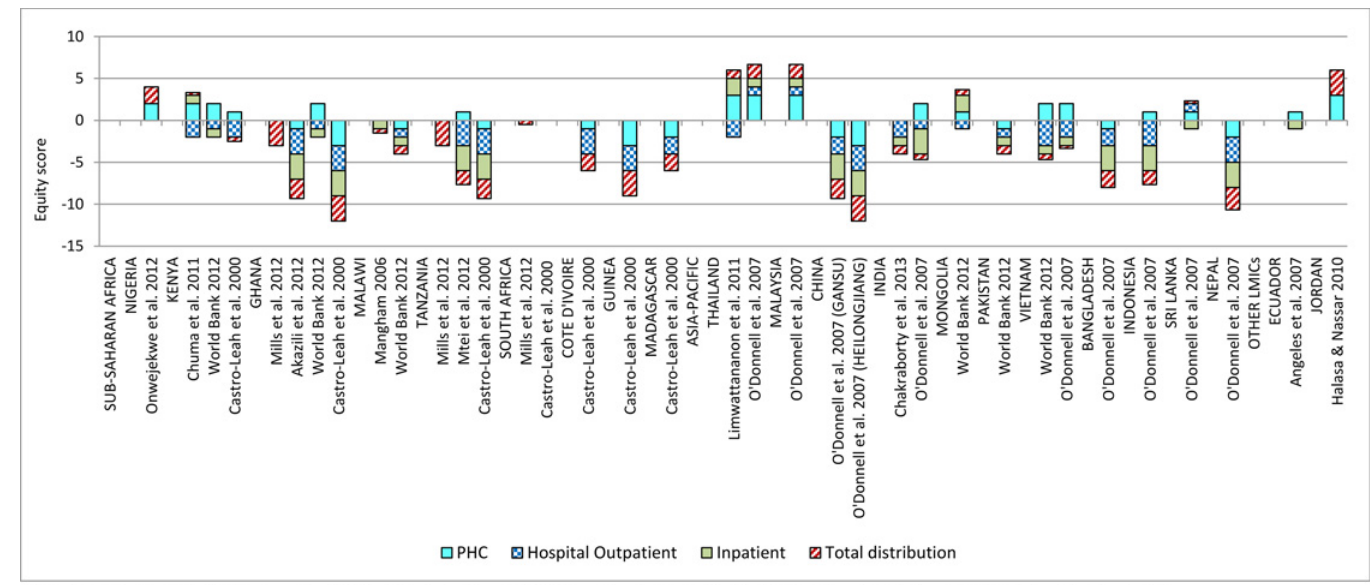
Fig 2. Equity scores from the BIA studies depicting the distribution of health care